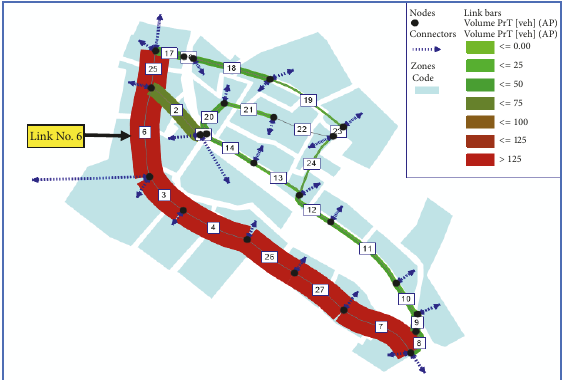
Figure 5: Study area (Ajka, Hungary), showing observed traffic flows on the transport network [27].